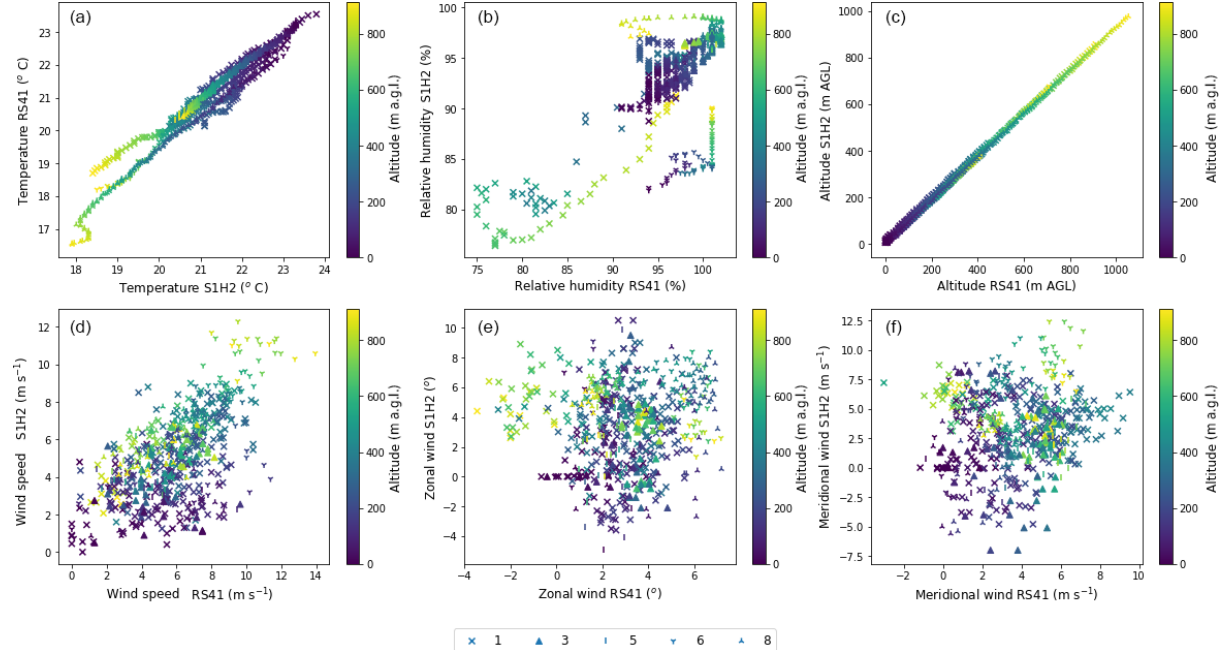
Figure 9. Comparison of temperature (a) , relative humidity (b) , altitude (c) , wind speed (d) , zonal winds (e) , and meridional winds (f) recorded by the Windsond S1H2 and the Vaisala during the DACCIWA field campaign in Kumasi. Each marker corresponds to the median value over a 1hPa range for all the flights where the S1H2 was used for the first, second, third, fourth, fifth, sixth and eighth time. The colours are based on the Vaisala RS41-SG-measured altitude with the maximum altitude set to